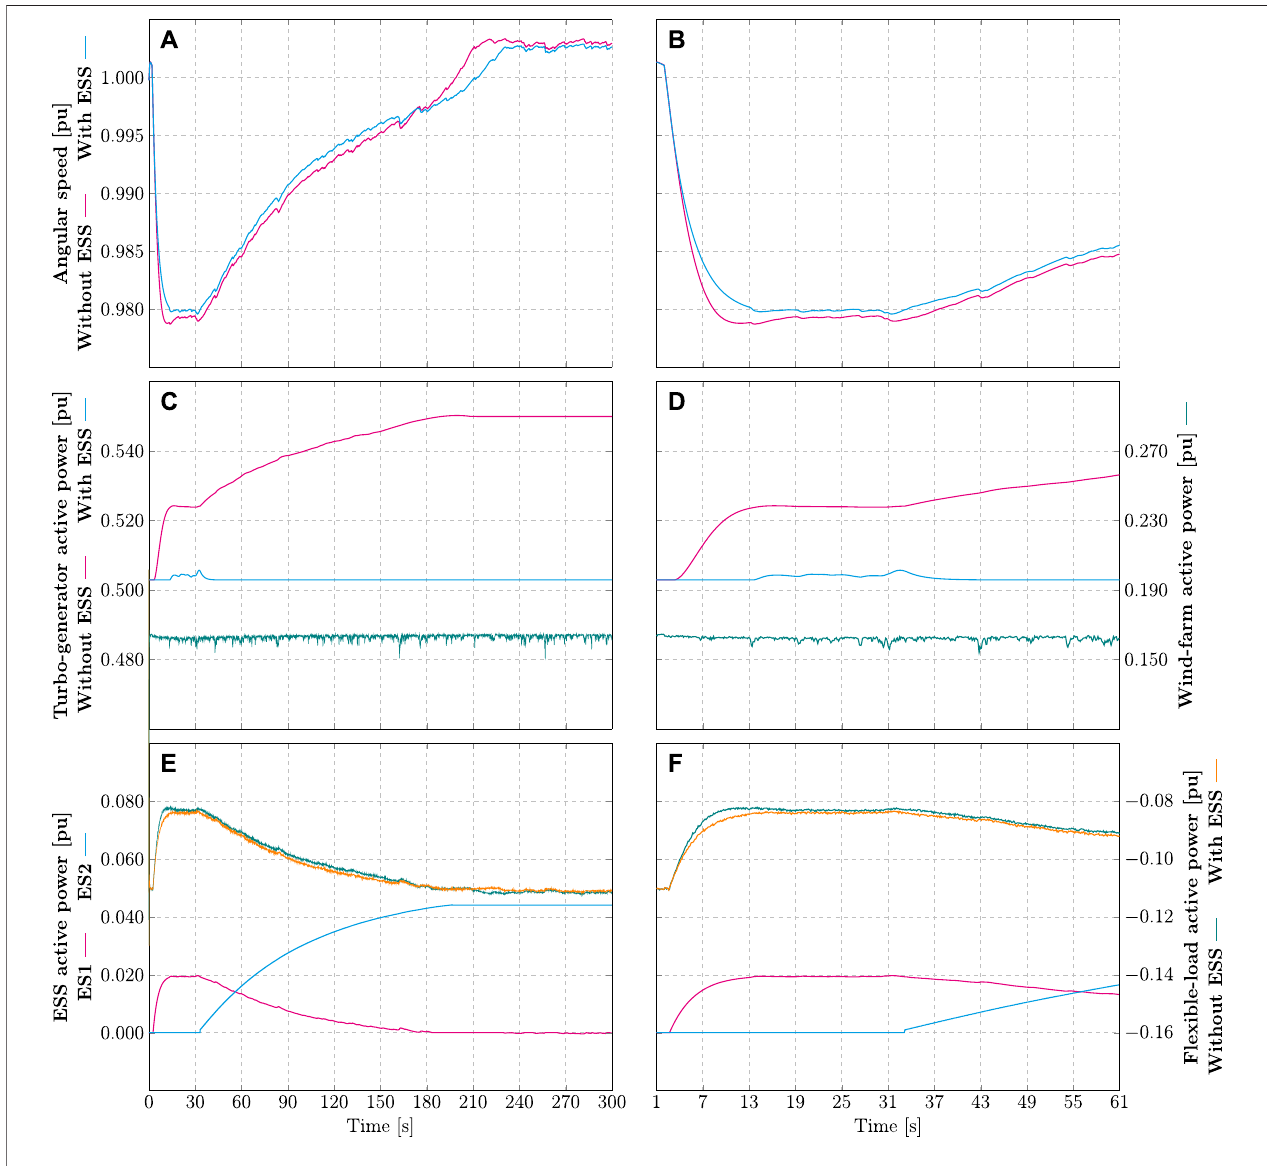
FIGURE9| Casestudybehaviorduringaloadincreaseof3 MWwithandwithouttheproposedESS:normalizedangularspeed (A) duringthewholetransientand (B) detail of the fi rst minute; turbo-generator and wind farm active power in pu (C) during the whole transient and (D) detail of the fi rst minute; active power of the ES devices responsible for primary control (ES1) and secondary control (ES2) (E) during the whole transient and (F) detail of the fi rst minute.